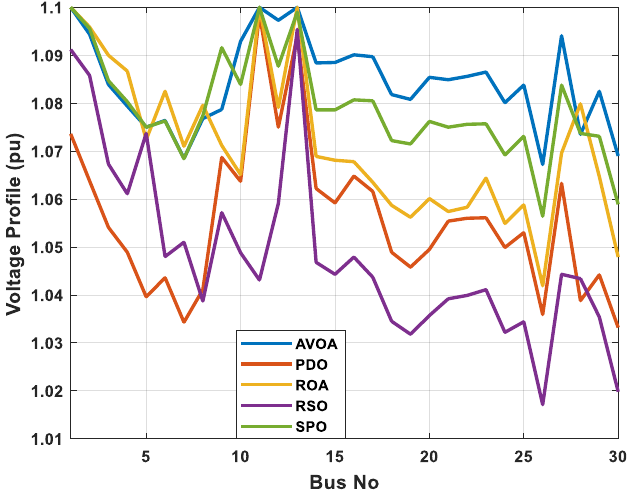
Figure 7. The AVOA convergence characteristics with the other compared methods for case 3.